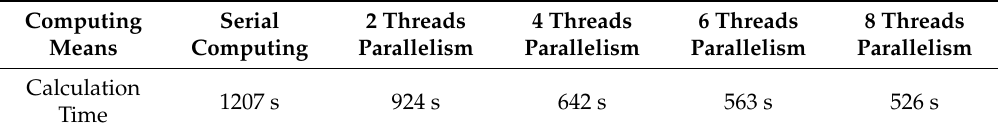
Table 1. Computing time of di ff erent computing means.